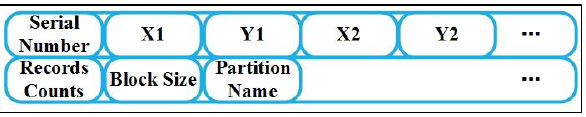
Figure 2. Global index structure